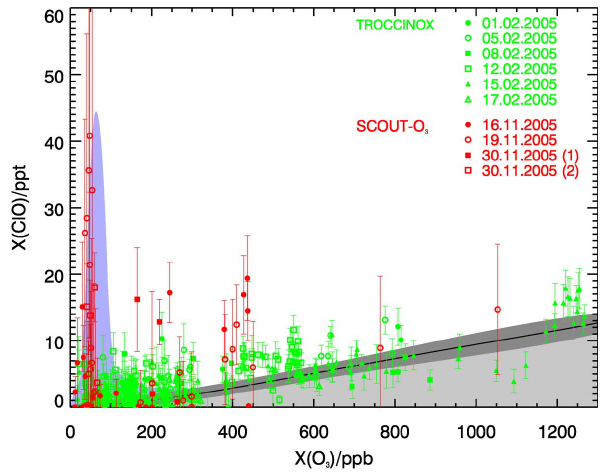
Fig. 3. Relation between ClO and Ozone in the tropical UTLS. Symbols represent HALOX measurements made during TROC- CINOX and SCOUT-O 3 field campaigns with error bars repre- senting combined uncertainties from accuracy and precision. The black line shows ClO mixing ratios expected at local noon based on CLaMS ST box-model simulations without heterogeneous reac- tions included; the range of values due to uncertainties in the Cl y - O 3 correlation and temperature is shown in dark grey. ClO mixing ratios observed at times significantly before or after local noon are expected to fall below this line as indicated by the light grey area. Blue shading indicates the range of ClO predicted with heteroge- neous chemistry included; the upper limit is defined by the simula- tion with highest Cl y (Fig. 1) and lowest temperatures (Fig. 2b).